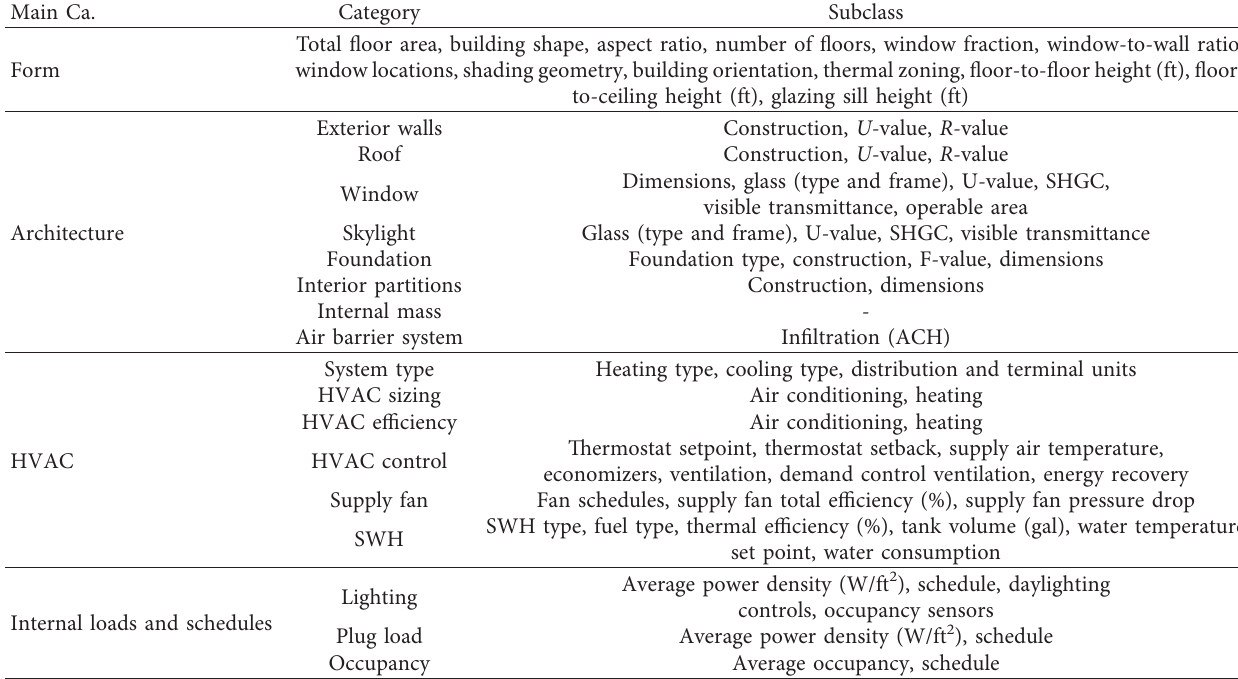
Table 1: Study of international building energy performance variables (ASHRAE, 2016).